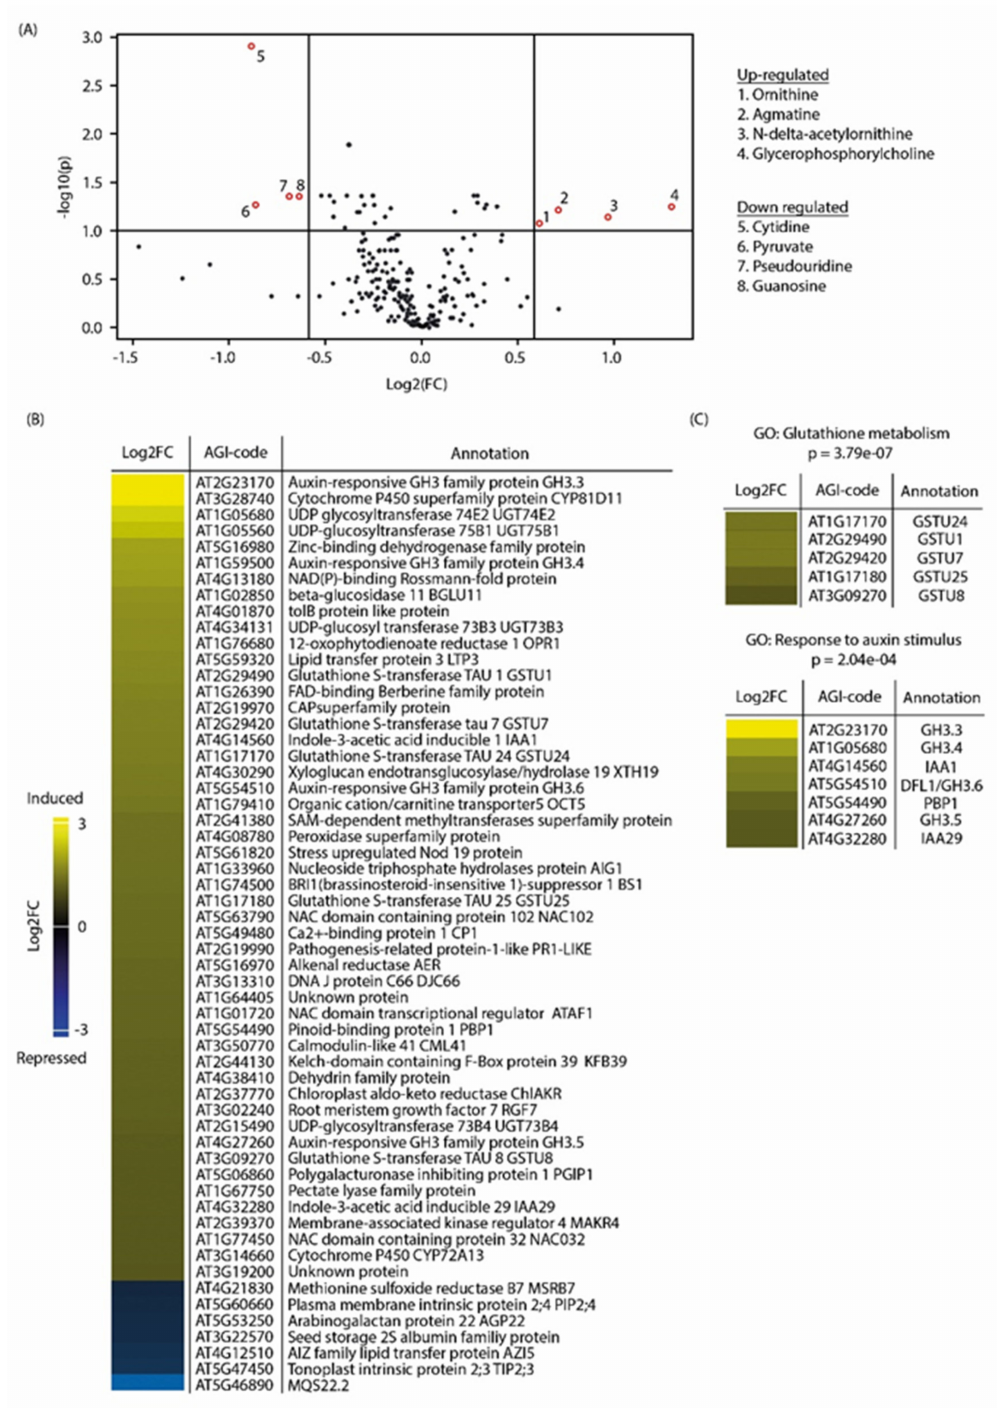
Figure 4. Transcriptome and metabolite changes triggered by pakerine in wild-type Arabidopsis . ( A ) Di ff erentially regulated metabolites ( | FC | ≥ 1.5; p ≤ 0.05) extracted from three-week-old plants grown in the presence of 1 µ M pakerine. Controls were exposed to DMSO. ( B ) Heat map of di ff erentially expressed transcripts ( | log2 FC | ≥ 1; adjusted p ≤ 0.05) in 10-day-old Arabidopsis seedlings treated with 5 µ M pakerine for 24 h. Controls received mock treatment with DMSO. ( C ) Gene ontology (GO) analysis of di ff erentially expressed transcripts depicted in ( B ). Shown are two significantly enriched clusters ( p <